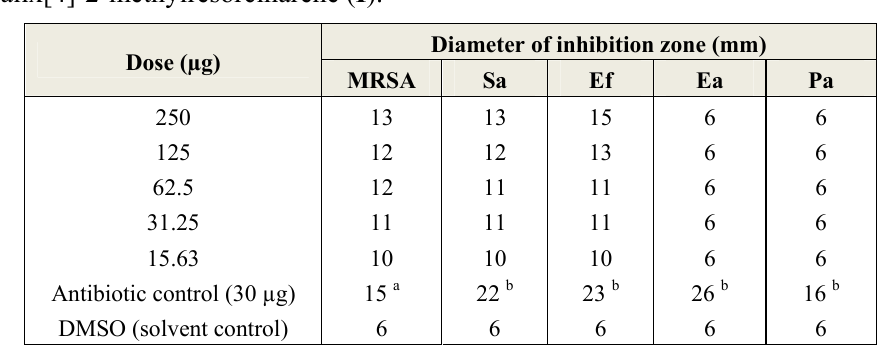
Table 3. Diameter of inhibition zone for antibacterial screening of